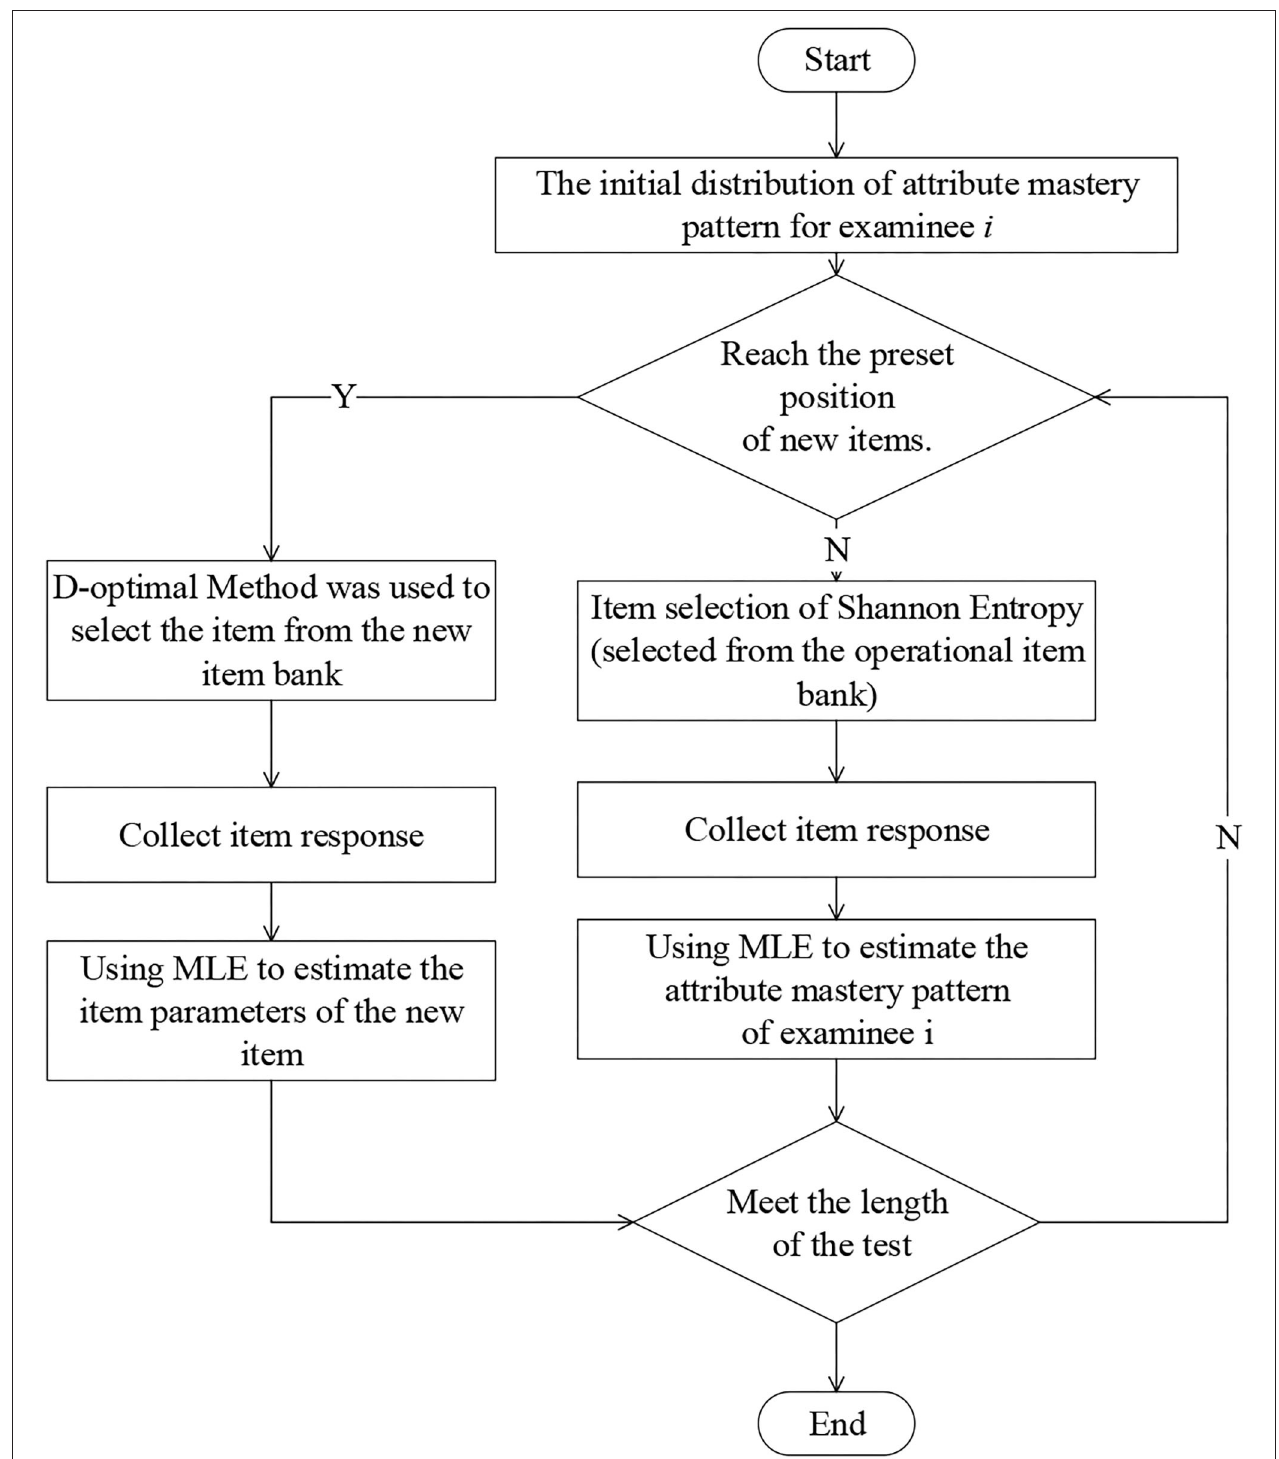
FIGURE 2 | The flow chart of the estimation of item parameters based on information information.